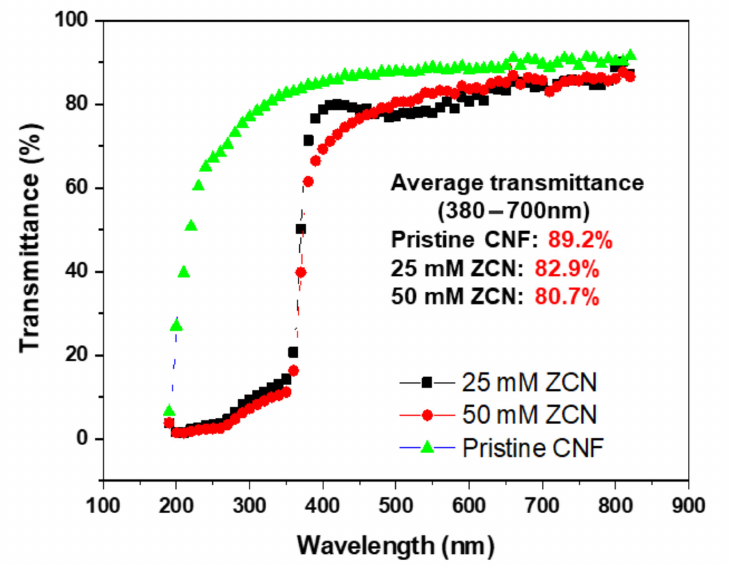
Figure 4. Optical transparencies of the pristine CNF film and ZnO-CNF